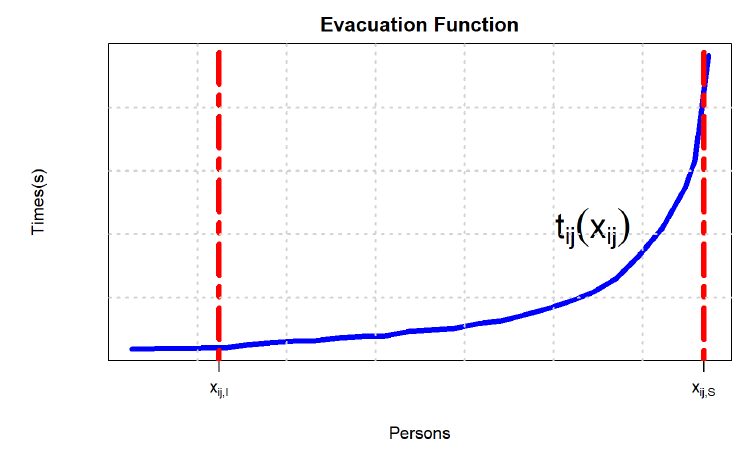
Figure 4. Function diagram of evacuation time and the number of